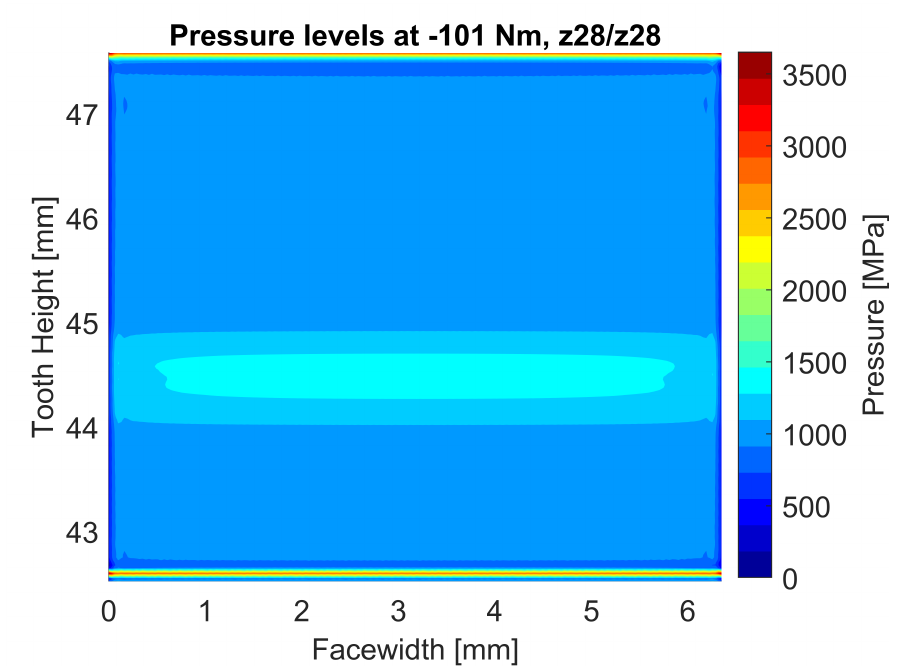
Figure 15. Flank pressure distribution of the tested gear pair without